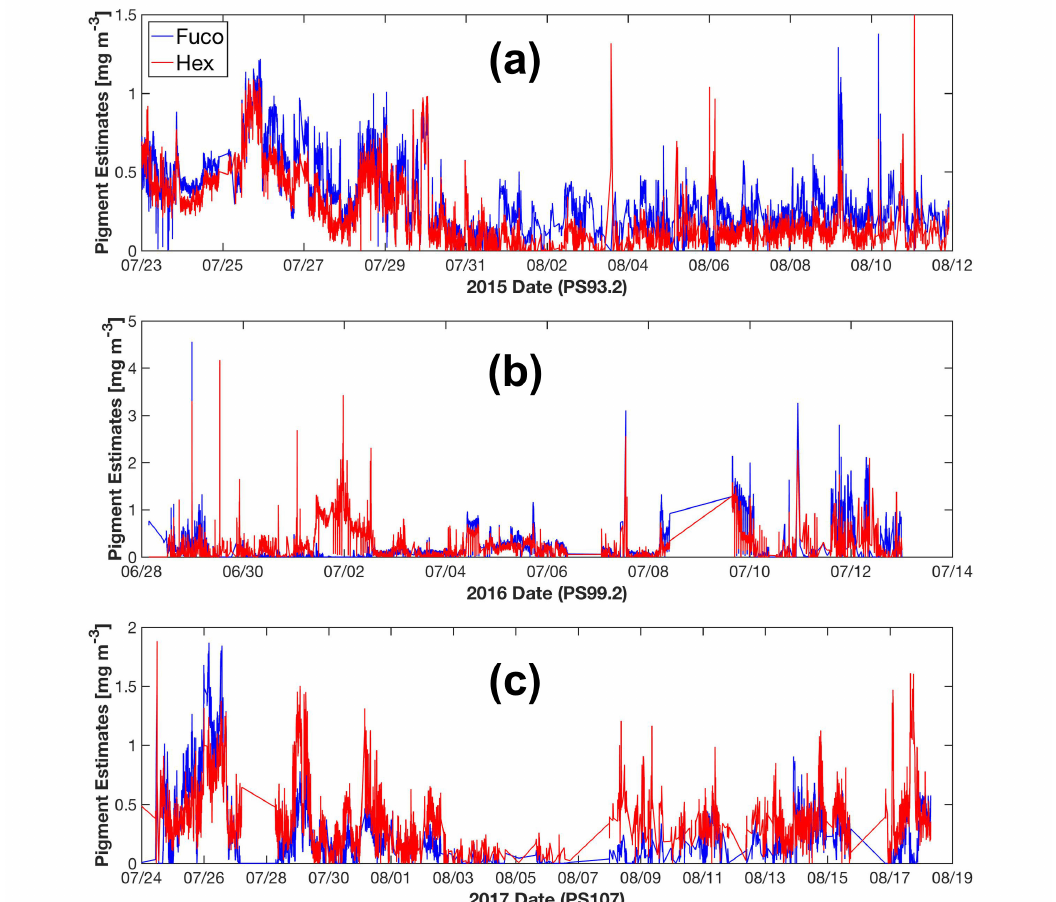
Figure 9. SVD-NNLS-9 estimated Fuco and Hex concentrations from underway spectrophotometry during the cruise periods of PS93.2 ( a ), PS99.2 ( b ) and PS107 ( c